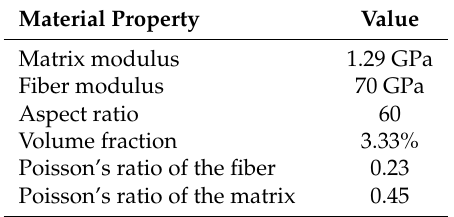
Table 1. Micromechanics input material properties, taken from